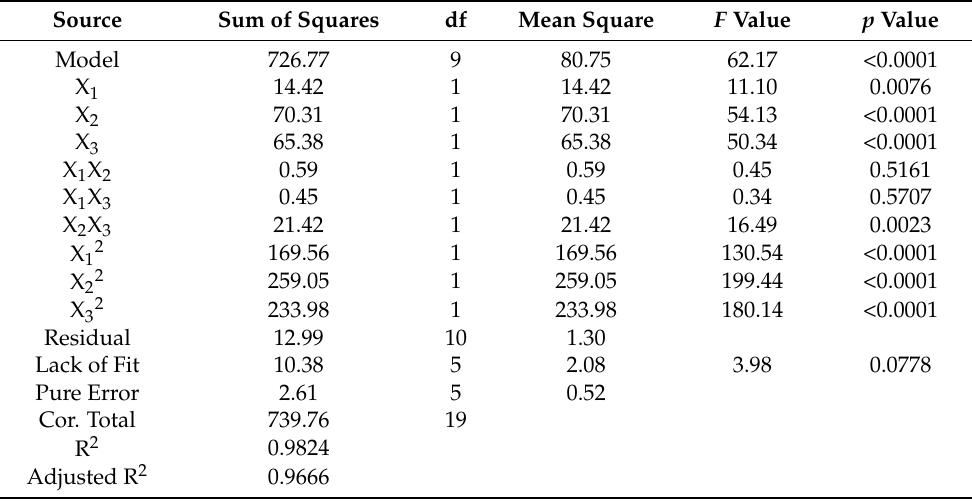
Table 2. Analyses of variance of the regression